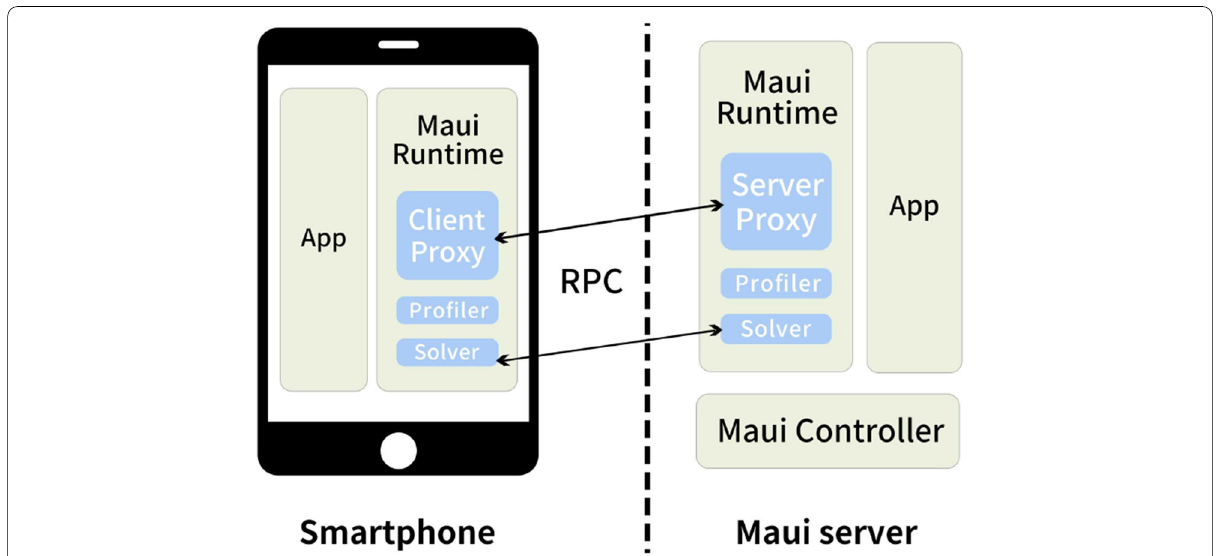
Fig. 2 Architecture of MAUI. (Cuervo et al.